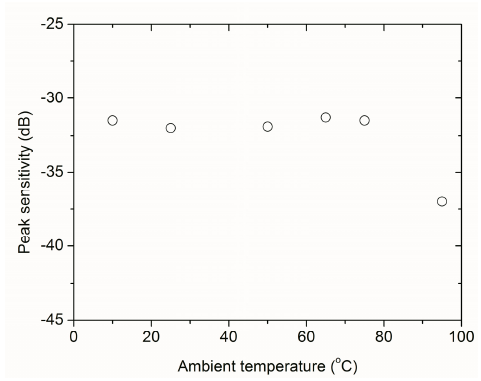
Figure 6. Variation in the peak sensitivity of a pair of air-coupled transducers (1 MHz) with the ambient temperature.